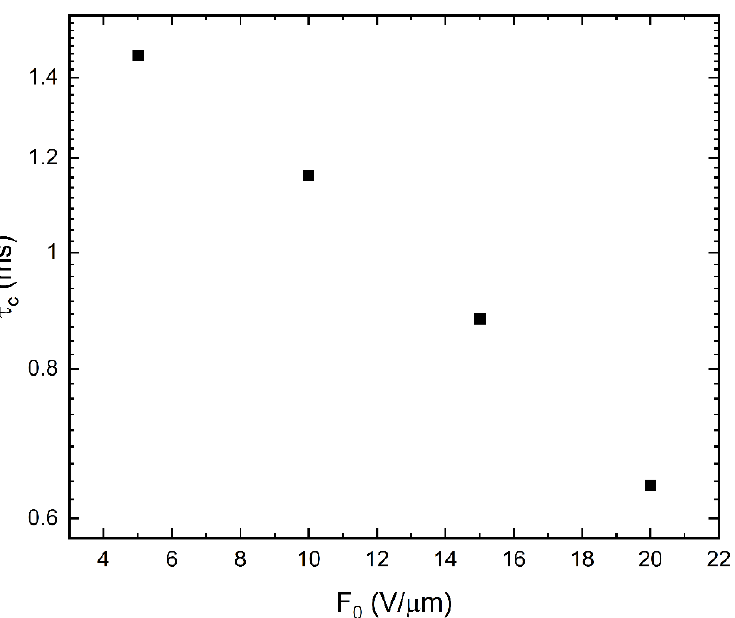
Figure 10. Capture time ( τ c ) plotted as a function of the applied nominal field ( F 0 ). A unique constant τ c was given for each applied nominal field to obtain the best fitting between experimental and simulated data.